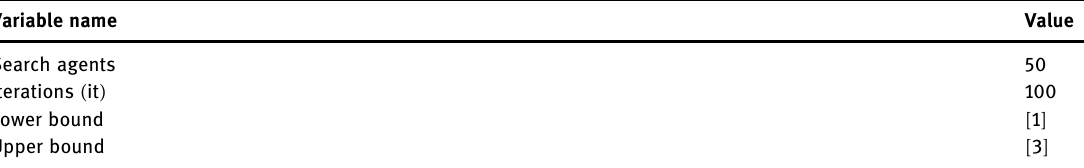
Table 3: MFO Initialization